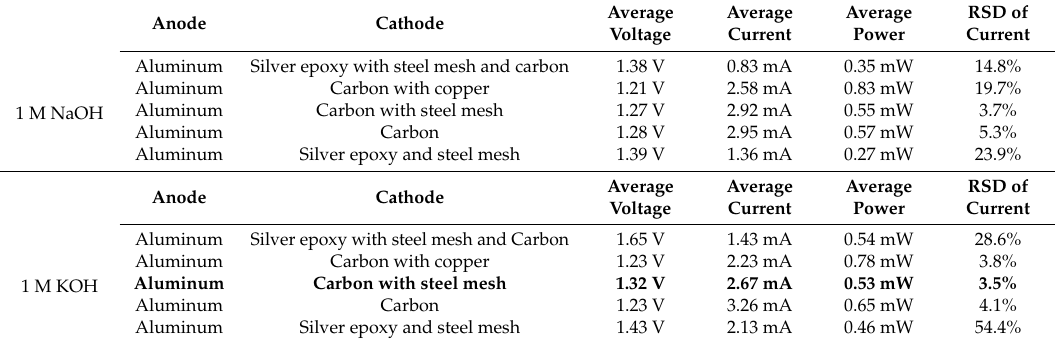
Voltage, current, and power of current collectors using a constant chip size 2.25 cm 2 (1.5 × 1.5 cm 2 ) and constant electrode size 0.5 cm 2 (1 × 0.5 cm 2 ). The optimal